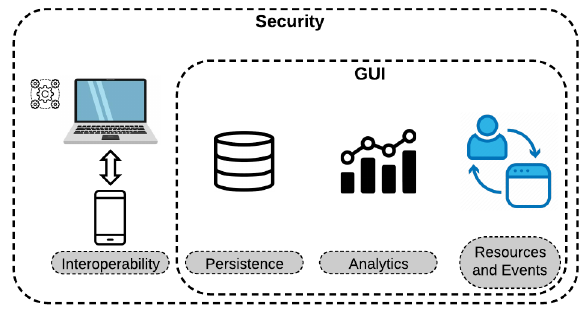
Figure 3. IoT Framework